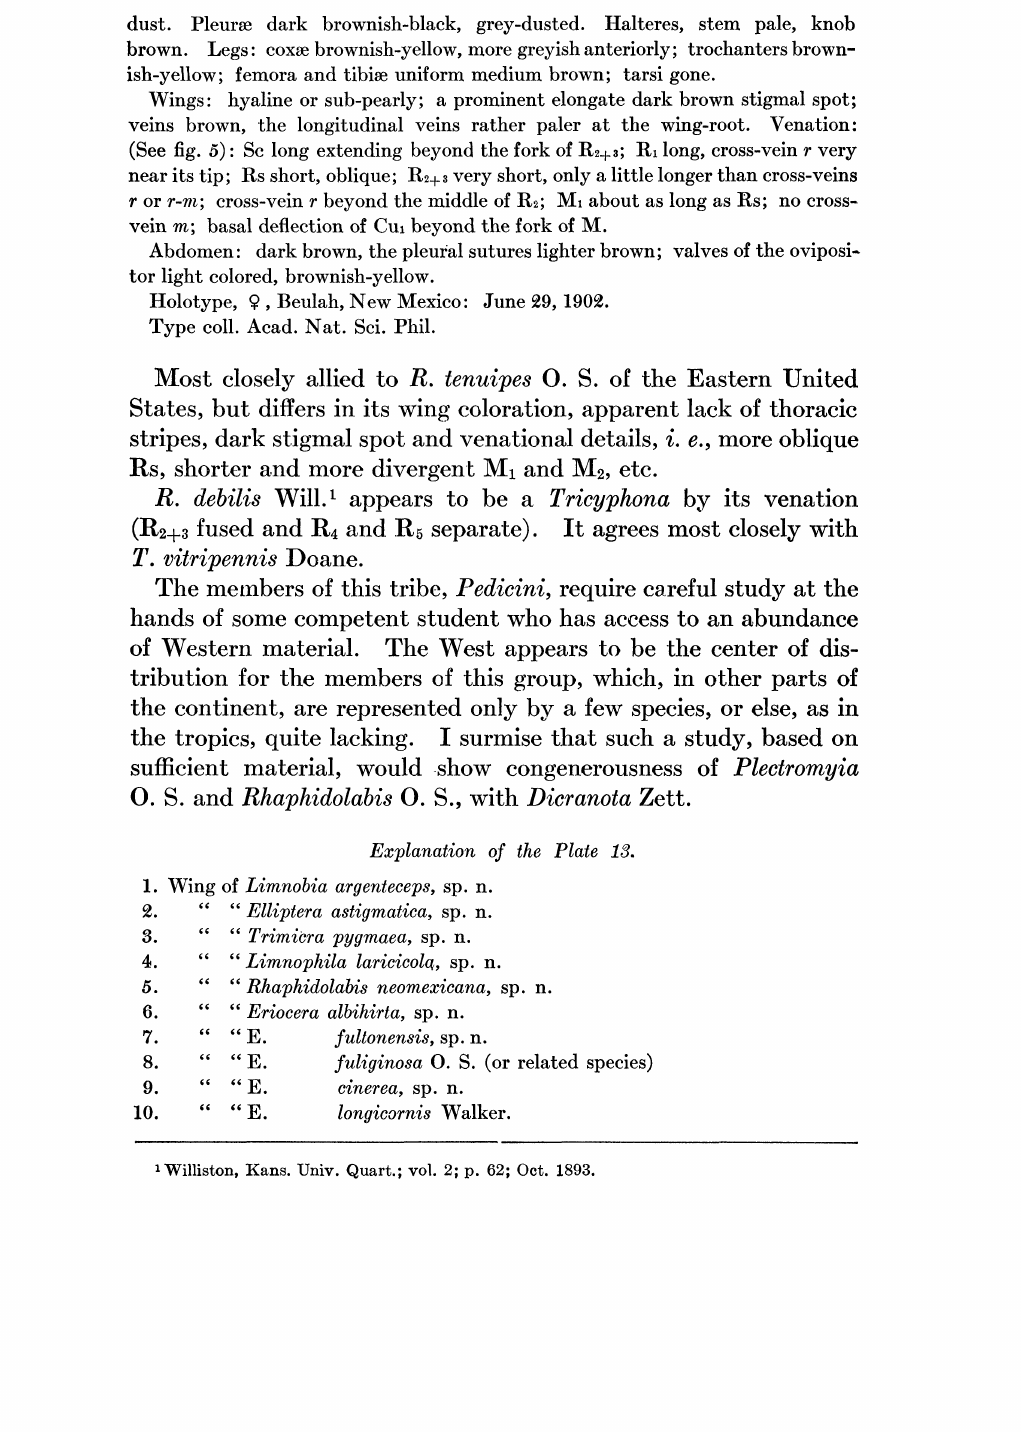
dust. Pleurae dark brownish-black, grey-dusted. Halteres, stem pale, knob brown. Legs: coxe brownish-yellow, more greyish anteriorly; trochanters brown- ish-yellow" femora and tibiae uniform medium brown; tarsi gone. Wings: hyaline or sub-pearly; a prominent elongate dark brown stigmal spot; veins brown, the longitudinal veins rather paler at the wing-root. Venation: (See fig. ,5): Sc long extending beyond the fork of R:+8; R1 long, cross-vein r very near its tip; Rs short, oblique; R:+a very short, only a little longer than cross-veins r or r-m; cross-vein r beyond the middle of R2; M1 about as long as Rs; no cross- vein m; basal deflection of Cu beyond the fork of M. Abdomen: dark brown, the plem’al sutures lighter brown; valves of the oviposi- , tor light colored, brownish-yellow. Holotype, Beulah, New Mexico: June 9,